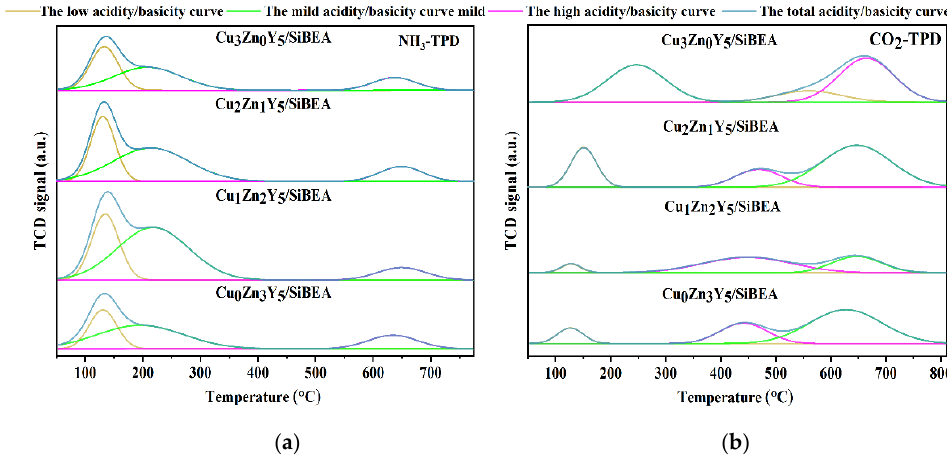
Figure 5. ( a ) NH 3 -TPD curves and ( b ) CO 2 -TPD curves of fresh CuZnY/SiBEA catalysts.